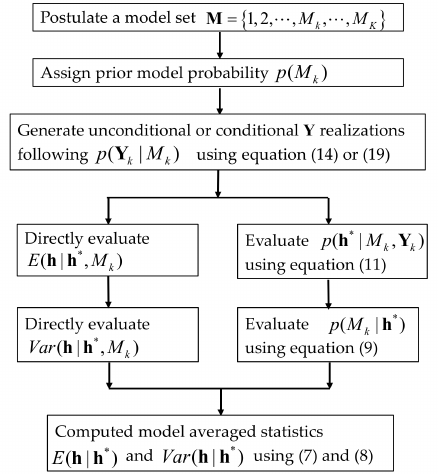
Figure 1. Flowchart for Monte Carlo (MC)-based multi-model analysis.